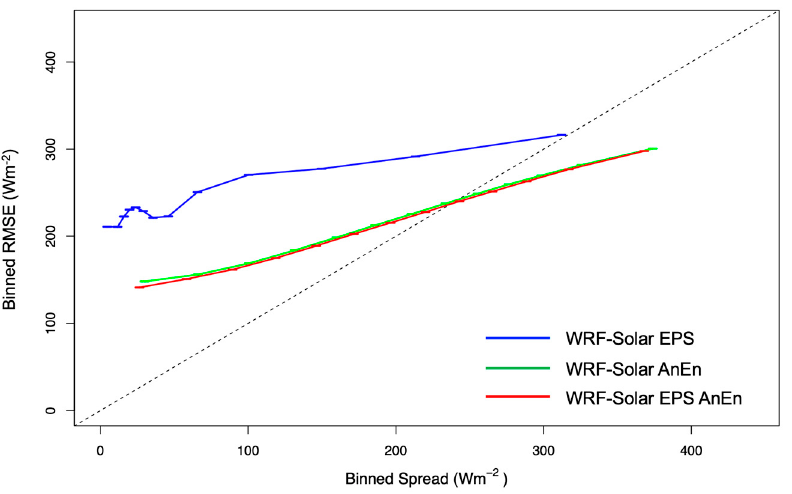
Figure A5. Binned RMSE/spread diagrams are computed by pooling all the grid points for DNI forecasts, runs, and the forecast lead times from +24 to +48 h for 2018. The horizontal bars represent the 5–95% bootstrap confidence intervals of the spread for each considered bin.